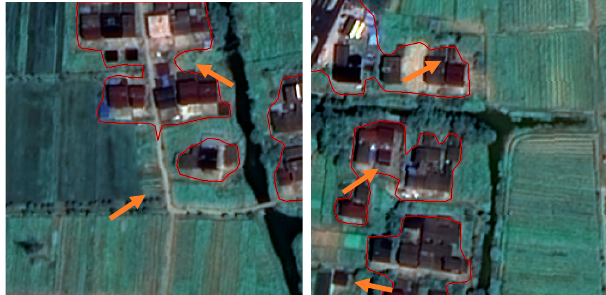
Figure 9. Detailed comparison between our proposed method and FCN based models at subset areas ( a ) and ( b ). The arrows indicate that some impervious surfaces can be extracted accurately by utilizing object-based deep CNNs, while by using the FCN-based models, the salt and pepper noises still persist and detailed boundaries are often smoothed.